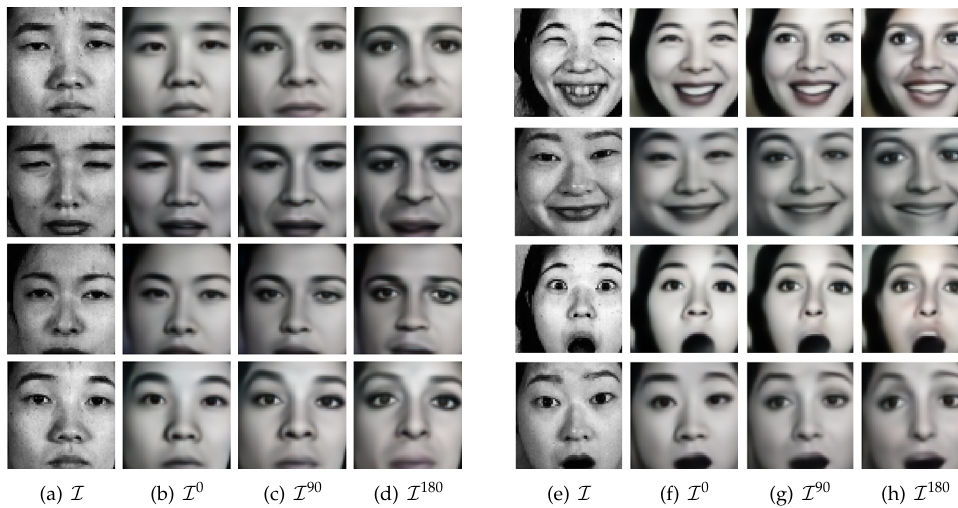
Figure 8. Results from the Japanese Female Facial Expression (JAFFE) dataset. ( a , e ) show original input images, ( b,f ) show reconstructed images (i.e. rotated with 0 degrees), ( c,g ) show de-identified faces by rotating 90 degrees, and ( d,h ) show de-identified faces by rotating 180